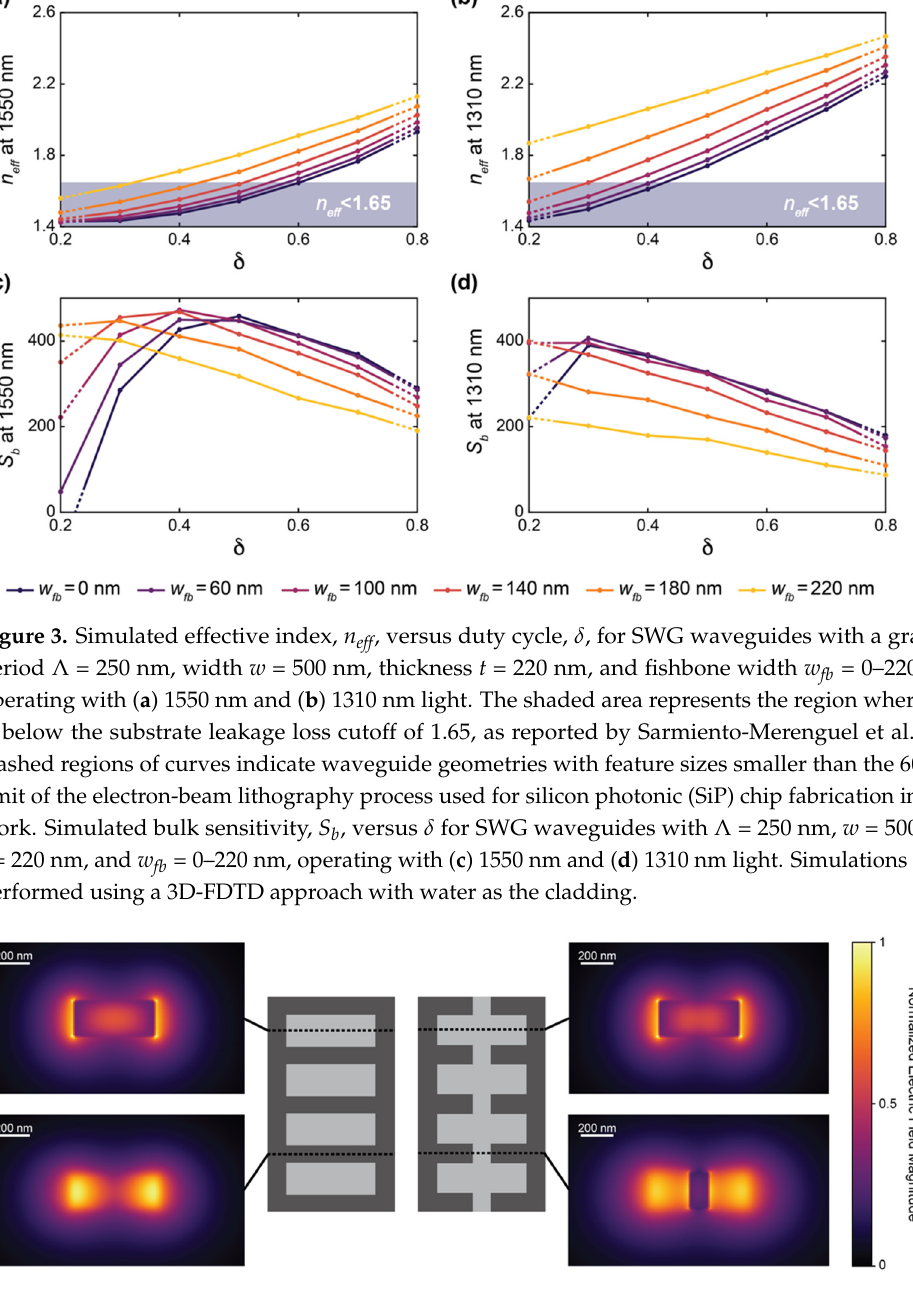
Figure 4. Cross-sectional electric field profiles for boneless ( left ) and fishbone ( right ) SWG wave- guides obtained from 3D-FDTD simulations at 1550 nm, illustrating the electric field intensity in the silicon blocks and gaps between these blocks. The boneless SWG field profiles were simulated for a waveguide with the following geometry: Λ = 250 nm, w = 500 nm, t = 220 nm, δ = 0.65, and w fb = 0 nm ( n eff = 1.70). The fishbone SWG field profiles were simulated for a waveguide with the following geometry: Λ = 250 nm, w = 500 nm, t = 220 nm, δ = 0.60, and w fb = 100 nm ( n eff = 1.70). The data presented in all subplots have been normalized to the same maximum electric field intensity.